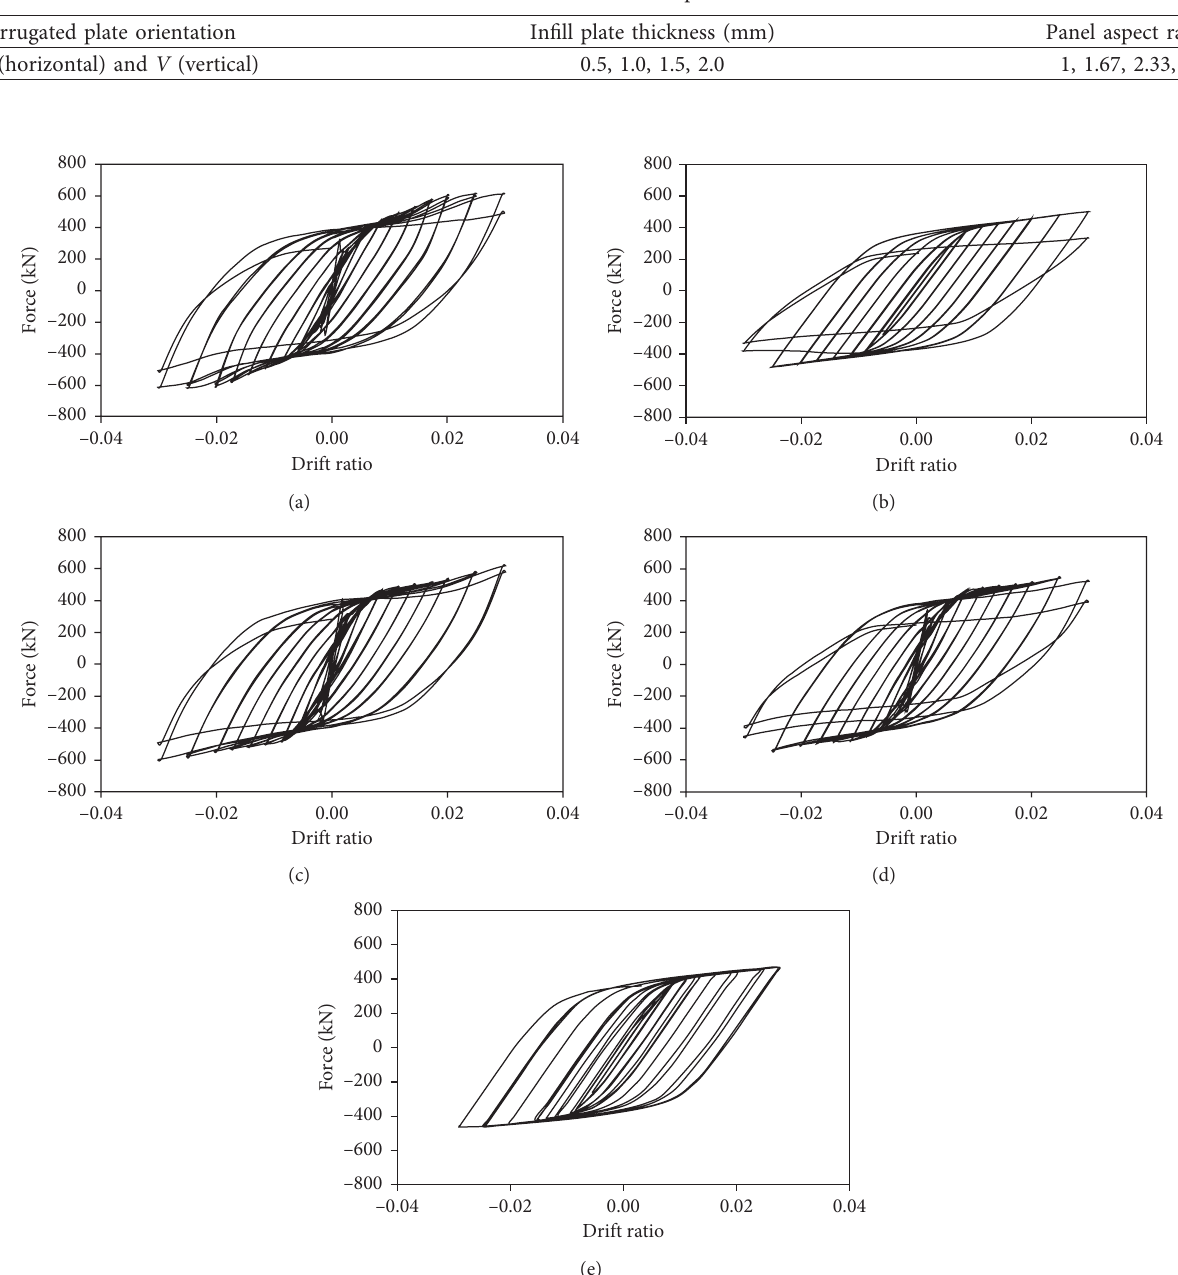
Table 3: Variations of CSPSW